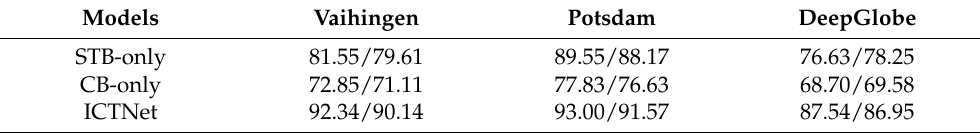
Table 7. Results of the ablation study of STB and CB. The accuracy is in the form of mean